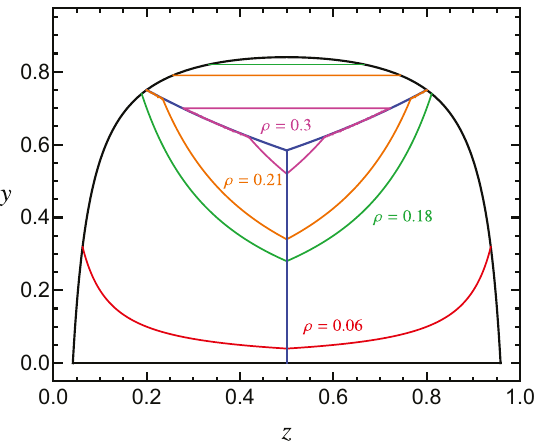
Figure 12 . Three-particle phase space (black lines), thrust boundaries (blue lines) and constant (cid:26) value contour lines, with ^ m = 0 :